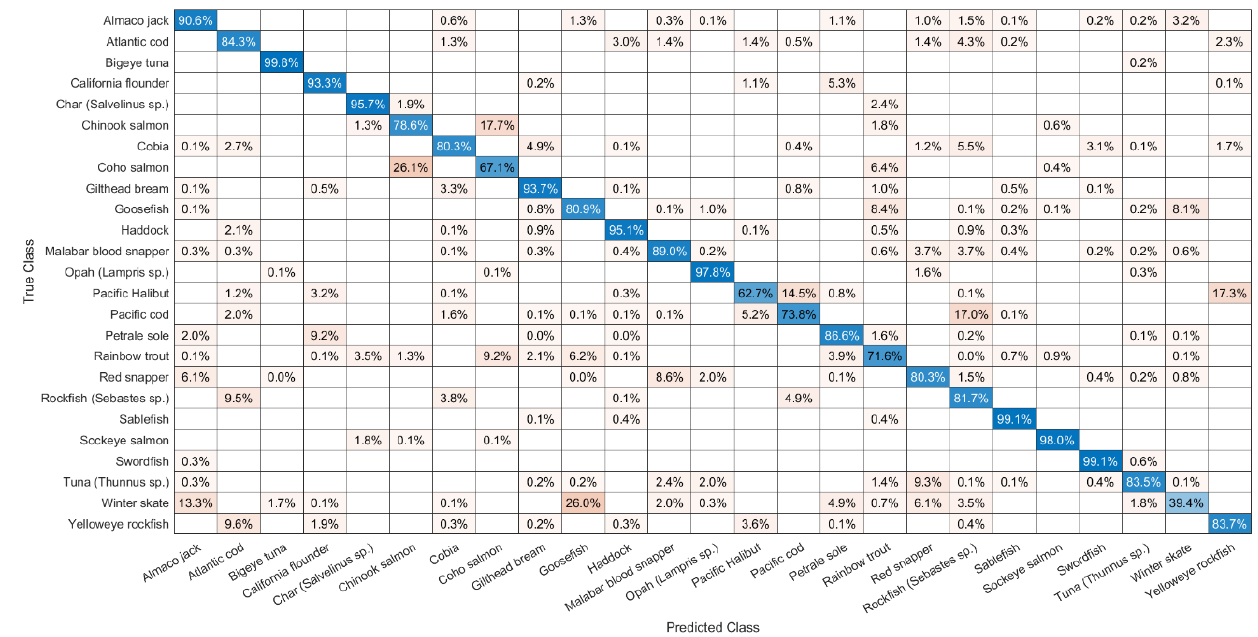
Figure 10. Confusion matrix for the single-mode VNIR results with the k = 7 MLP (overall classification accuracy = 82.7%).